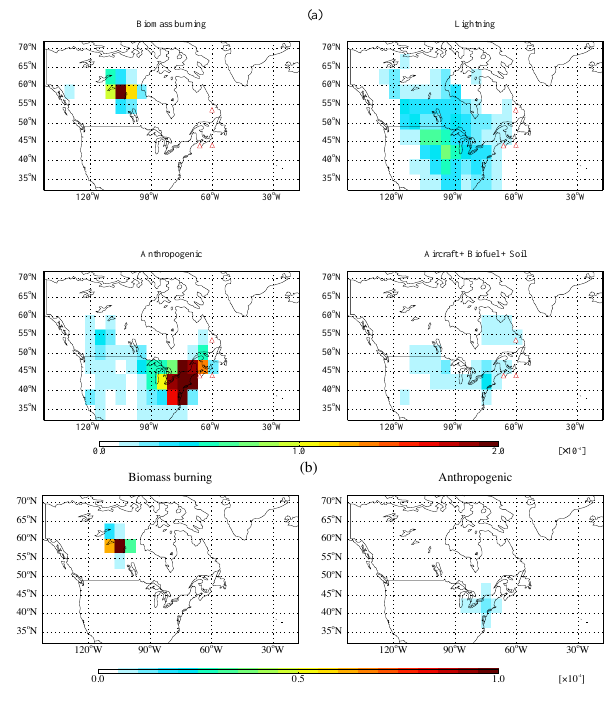
Fig. 9. Normalised cost function sensitivity of model free tropospheric (approximately 750–250hPa) ozone profiles over ozonesonde launch sites in Maritime Canada to: (a) NO x emis- sions estimates associated with biomass burning, lightning, anthro- pogenic, and combined aircraft/biofuel/soil sources; and (b) CO emissions estimates associated with biomass burning and anthro- pogenic sources over the BORTAS-A campaign period (12 July to 4 August 2010). The ozonesonde launch site locations (Goose Bay, Sable Island, and Yarmouth from Table 1) are denoted by red trian- gles in each